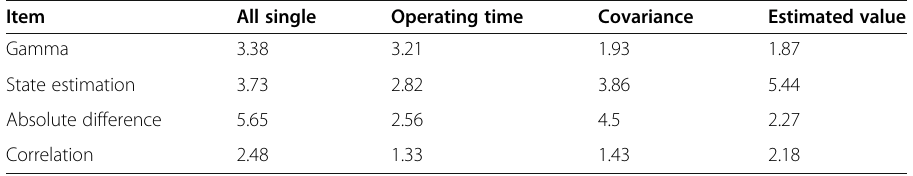
Table 4 The correlation probability of the algorithm Item All single